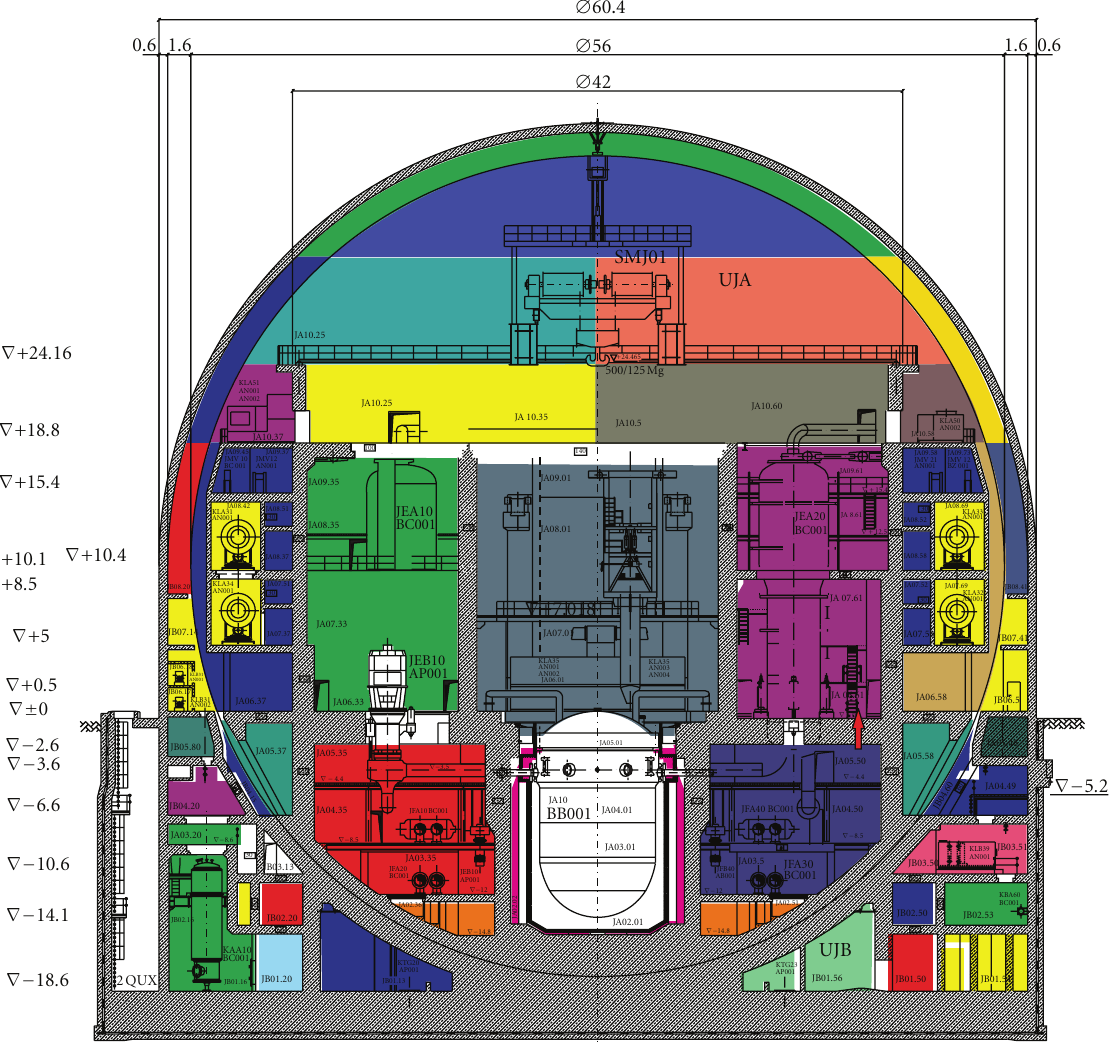
Figure 10: MELCOR nodalisation scheme of containment and reactor building annulus (principle